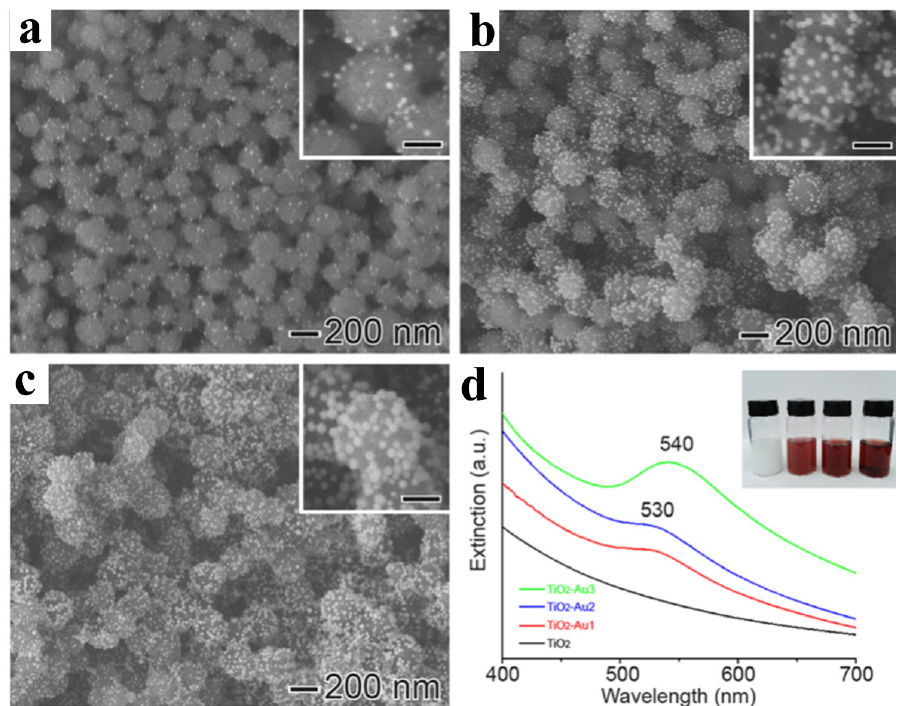
-Au colloidal spheres that were obtained after the first a) , Figure 14 - a-c) SEM images of TiO 2 second b) , and third c) reduction steps employing 3 mL of 1 mM AuCl 4- as the precursor solution. (aq) The scale bars in the insets correspond to 100 nm. d) UV-vis extinction spectra recorded for the TiO 2 (black trace) and TiO -Au (red, blue ang green traces correspond to samples showed in a , b , and c , 2 respectively). The inset depicts a photograph of TiO , and samples a , b and c , aqueous suspensions 2 (from left to right, respectively). Adapted with permission from ref. (Damato et al. 2013) Copyright 2013 American Chemical